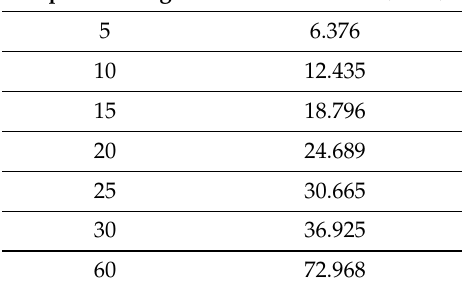
Table 16. Inference time obtained for the proposed model obtained for a sequence with variable number of